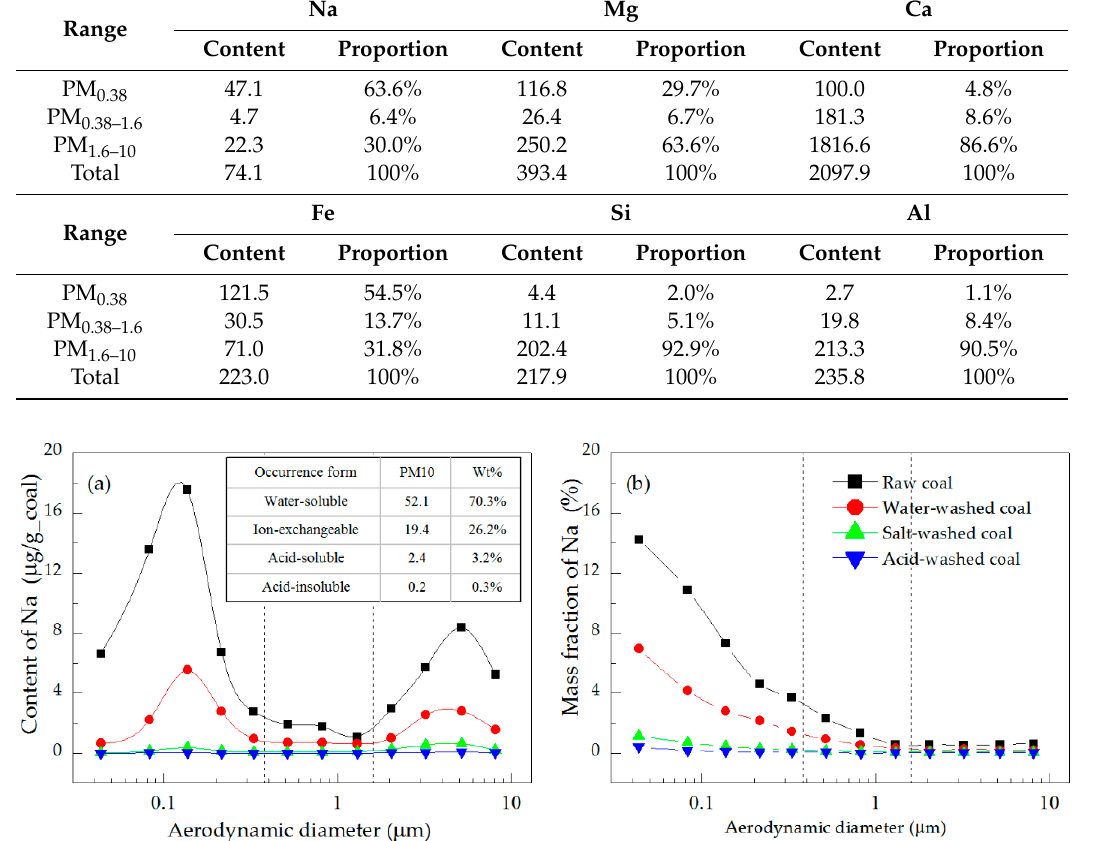
Figure 5. Distributions of the ( a ) content and ( b ) mass fraction of Na in the PM.